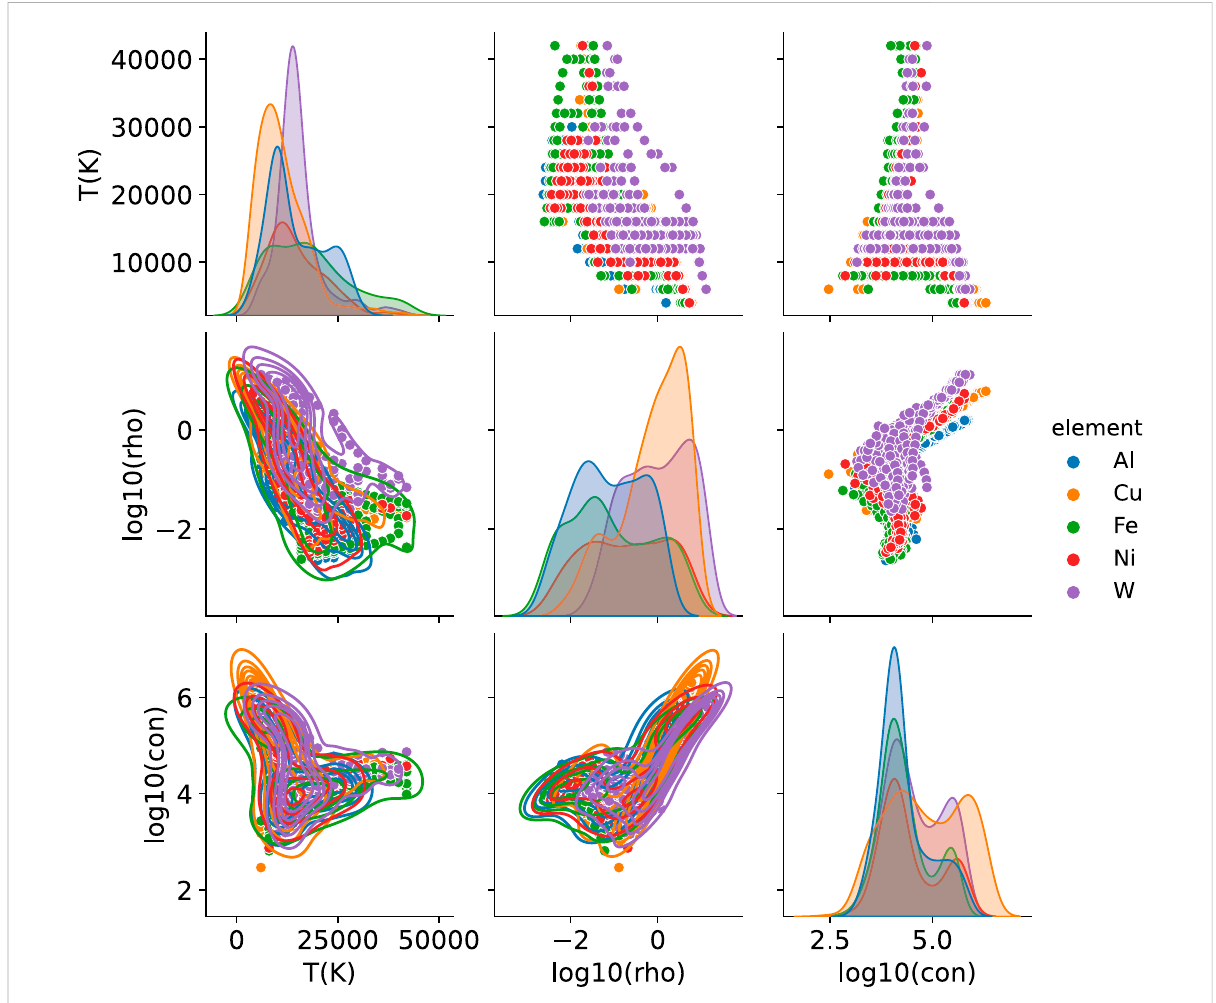
FIGURE 4 DK electrical conductivity data for all fi ve elements (Al, Fe, Ni, Cu and W) shown as histograms and scatter plots. Along the diagonal are the distributions of temperatures (in K), densities (log g/cc) and conductivities (log S/m). Note that some of the data are unbalanced toward lower temperatures or higher densities. Correlations between variables are shown in the off-diagonal plots, which reveal strong correlations between conductivity and density as well as between conductivity and